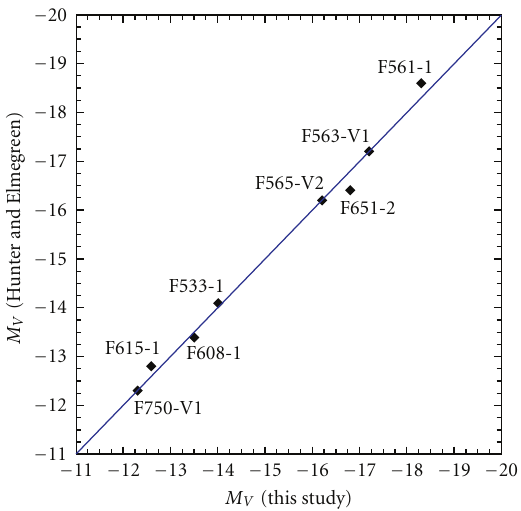
Figure 2: A comparison between V magnitudes determined by Hunter and Elmegreen and this study. The one-to-one correspon- dence line is shown in blue. The mean di ff erence is only 0.01 mags. The larger disagreement for the brightest galaxies (F561-1 and F651-2) is due to our technique of replacing stars with galaxy light.